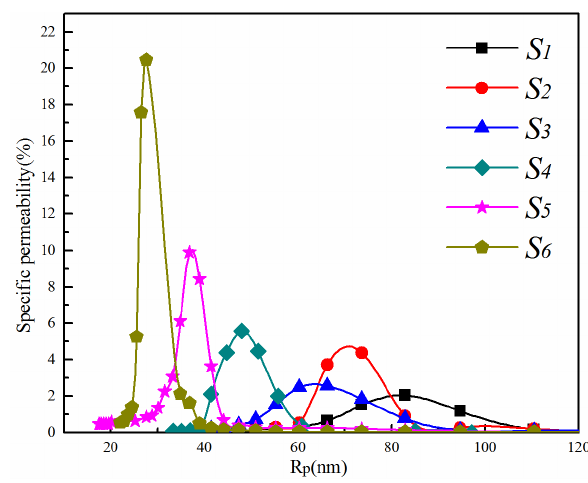
Figure 3. Pore size distribution curves of PVDF/PVA blend membranes S 1 – S 6 . Table 2. Mean pore size of PVDF/PVA blend membranes S 1 – S 6 .